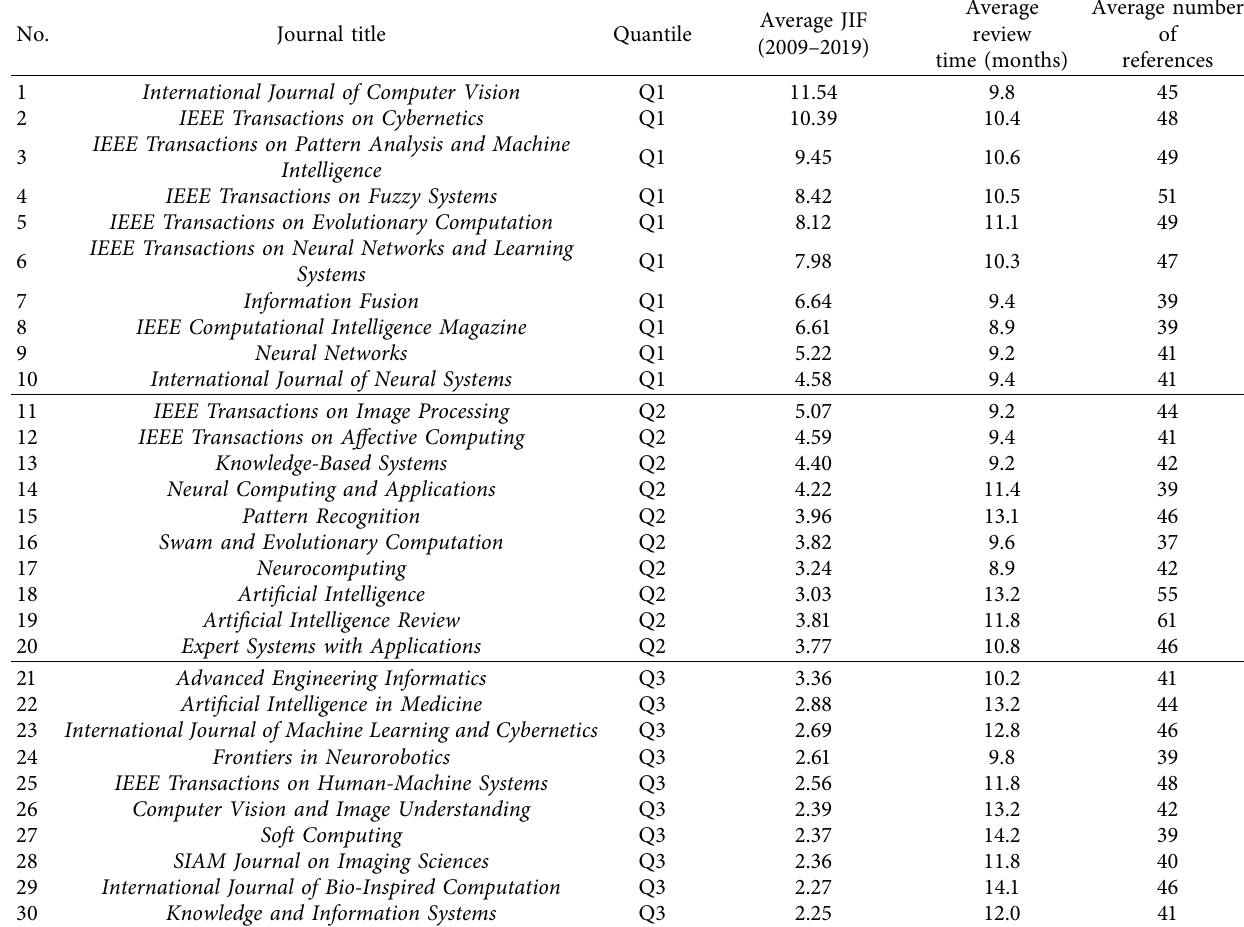
Table 4: Average JIF, average review time, and average number of references for 40 AI